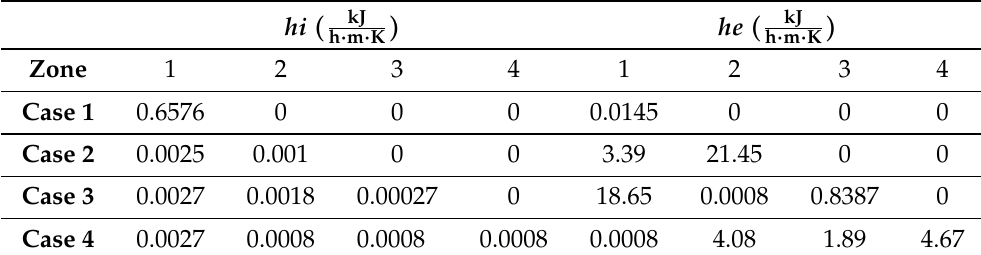
Table 3. Heat transmission coefficients for the discharging process.